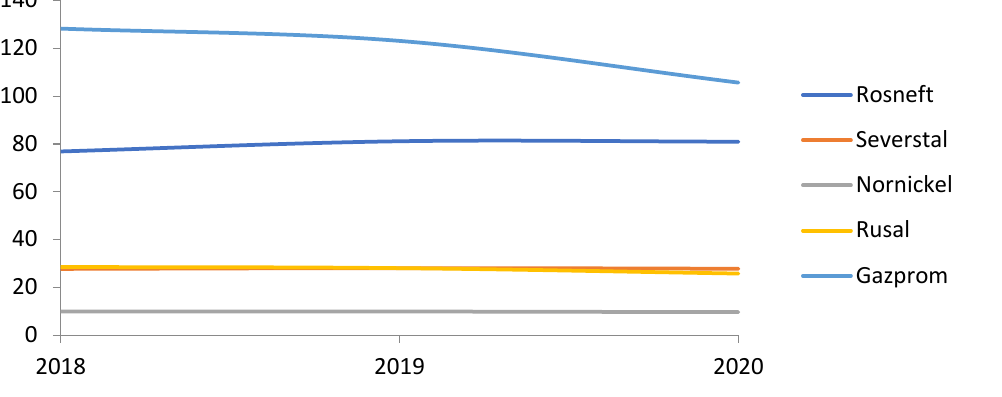
Figure 1. The graph of CO 2 emissions shows that the dynamics of the main companies is stable, with the exception of Gazprom, which shows the dynamics of reducing CO 2 emissions from 2019 to 2020. The data are given in million tons. The data are taken from the sustainability reports of companies for 2021.